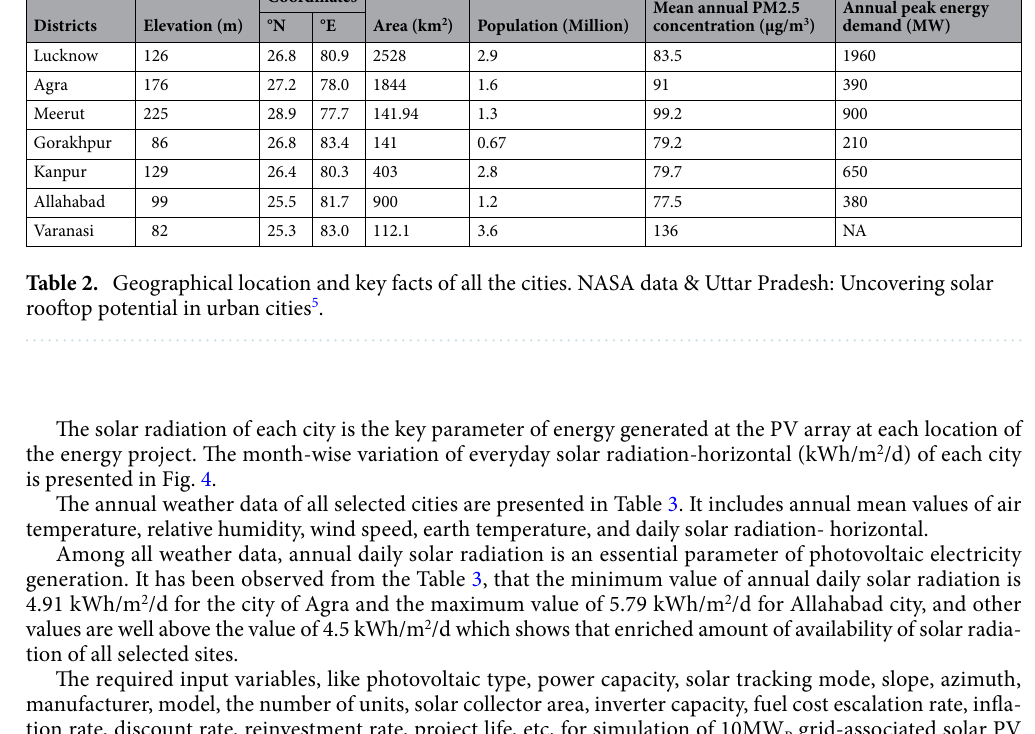
Districts Elevation (m)